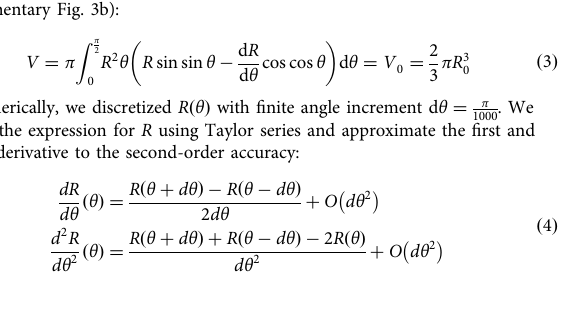
(overall) tension: T overall and k